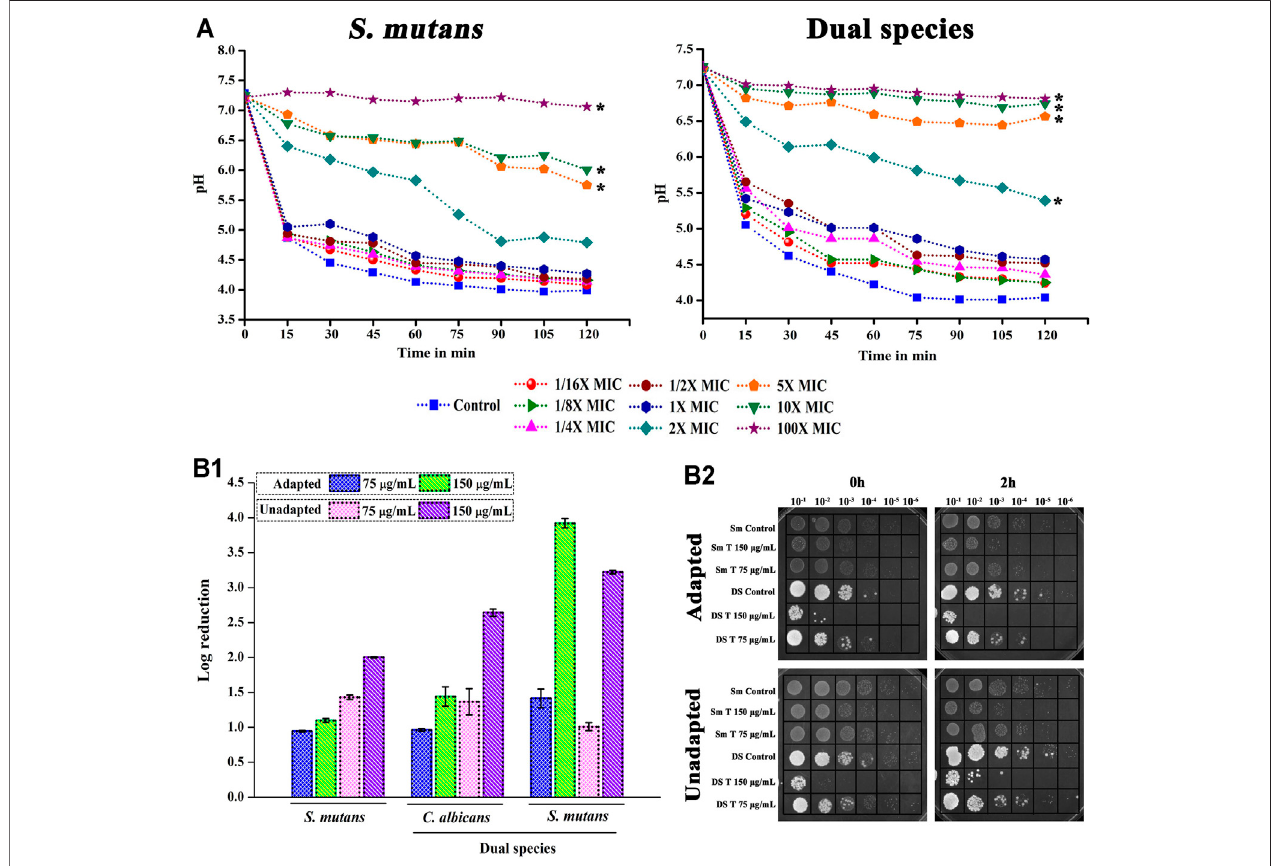
FIGURE 4 | Effect of thymol on acidogenicity and acidurance of S. mutans in single and dual species state. (A) Due to the interference of thymol in the glycolytic pathway, decline in the metabolism of glucose resulting in decreased acid production was observed in both single and dual species culture. (B) Thymol deteriorates the acid tolerance mechanism of S. mutans. (B-1) Log reduction in cfu/ml of pathogens habituated in acidic condition under the in fl uence of thymol; (b-2) spot assay con fi rming the reduction in microbial load. Error bars represent standard deviations from the mean and * indicates signi fi cance p < 0.05.